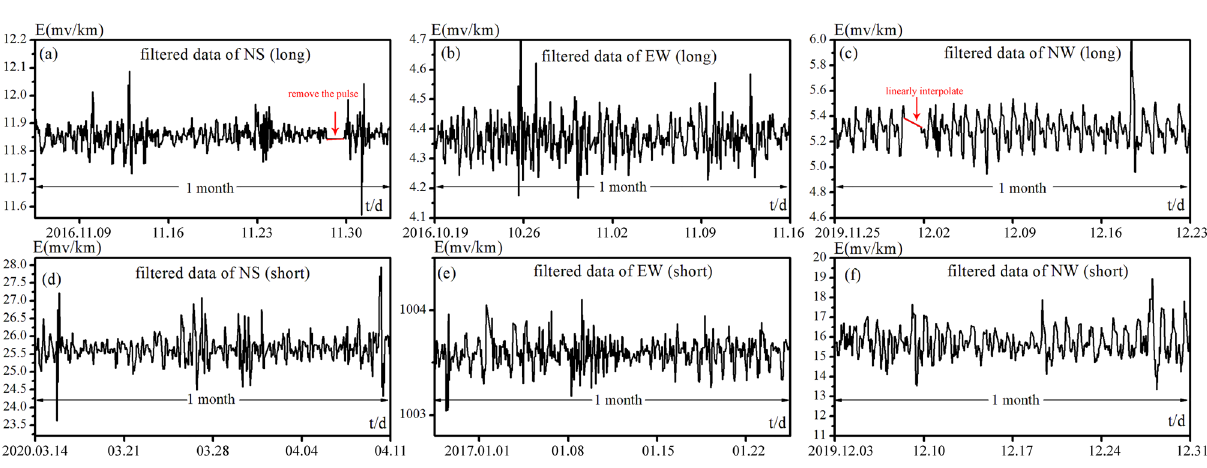
Figure 4. Examples of the preprocessed and filted geo-electric field data for one month. The unit of the horizontal axis is time, and ‘t/d’ means ‘time/day’. The applied processing method is plotted in the